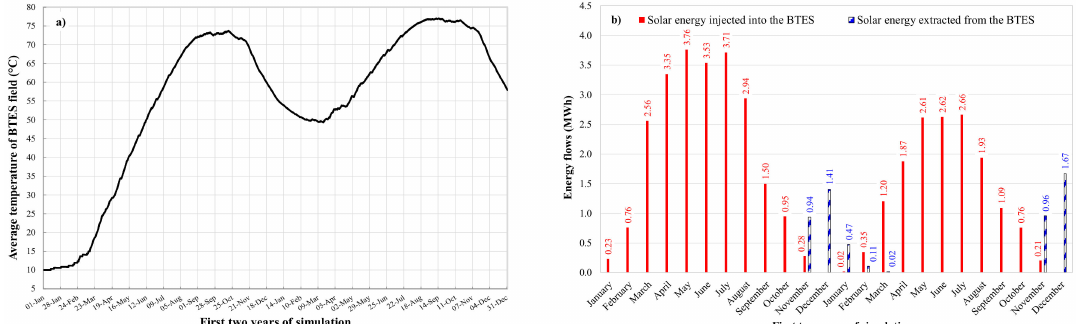
Figure 5. Average temperature of the ground in the storage volume during the first 2 years ( a ), monthly amount of solar energy charged / discharged into / from the BTES during the first 2 years ( b ), for the SCHEME